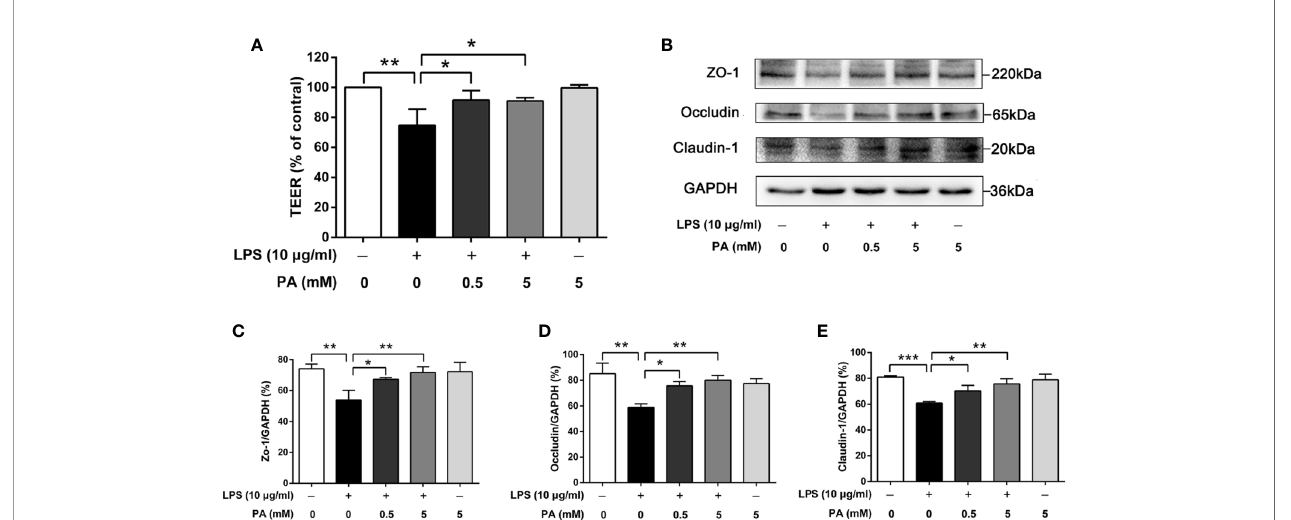
FIGURE 2 | The effects of PA on TEER and expression of tight junction proteins in LPS-induced IEC-6 cells. Cells were cultured in media with varying concentrations of PA (0, 0.5 and 5 mM) and LPS (l0 m g/ml) for 24 h. The indicated PA concentrations were maintained throughout the duration of the experiment. TEER was measured by epithelial voltohmmeter ERS-2. (A) The value of TEER. (B) The protein expressions of ZO-1, occludin, claudin-1 were determined by western blot analysis and were quanti fi ed in (C – E) . The data in the fi gures represent the averages ± S.D. Signi fi cant differences between the treatment and control groups are indicated as *P < 0.05, **P < 0.01, ***P < 0.001. Signi fi cance was determined by one-way ANOVA.